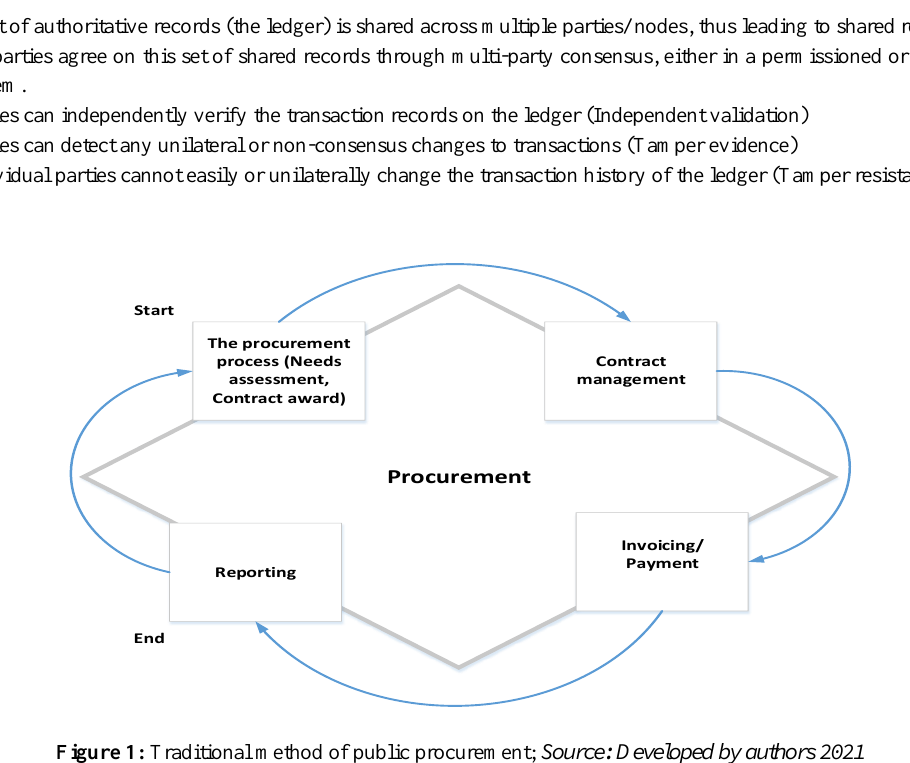
Figure 1: Traditional method of public procurement; Source: Developed by authors